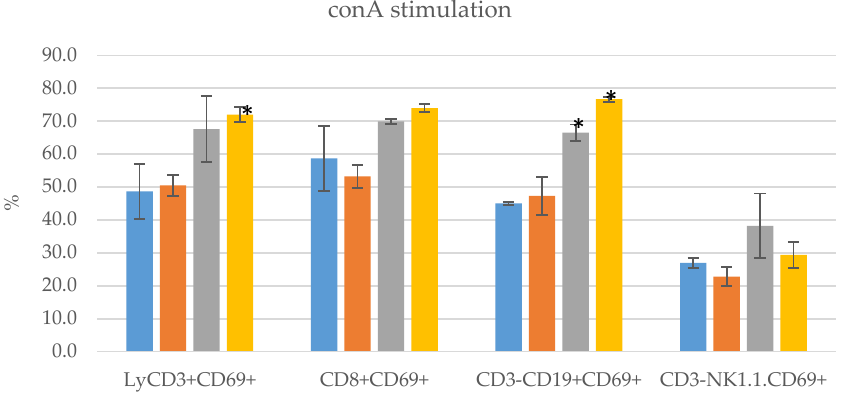
Table 13. The effect of administering ImunoBoost in three different concentrations on the expression of the CD69 marker on lymphocyte surfaces in mice—stimulation with conA; * p = p value.